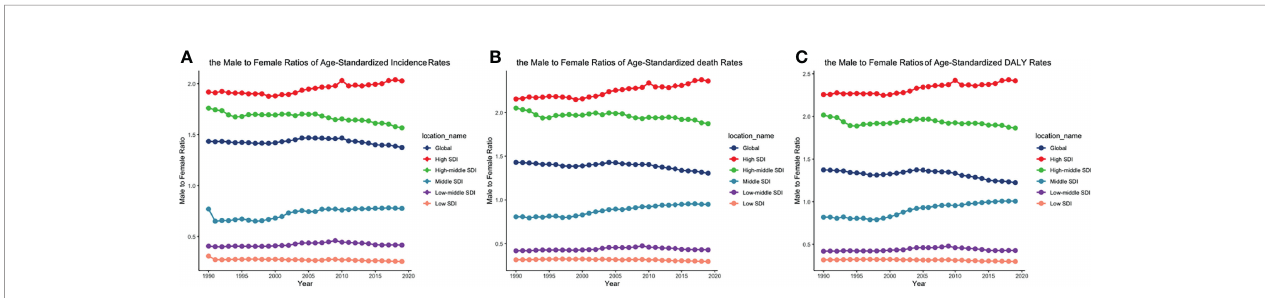
FIGURE 6 | The male-to-female ratios of (A) ASIR, (B) ASDRs, and (C) age-standardized DALY rates by SDI quintiles from 1990 to 2019. (ASIR, age-standardized incidence rate; ASDR, age-standardized death rate; DALY, disability-adjusted life year; SDI, socio-demographic